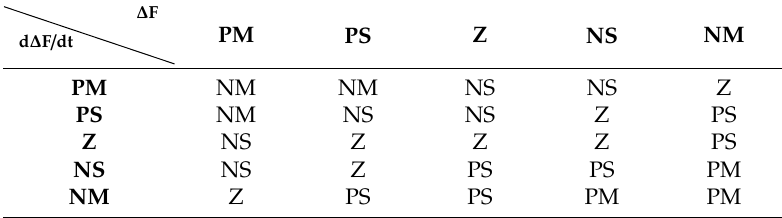
Table 7. Fuzzy rules of the fuzzy logic controller of the